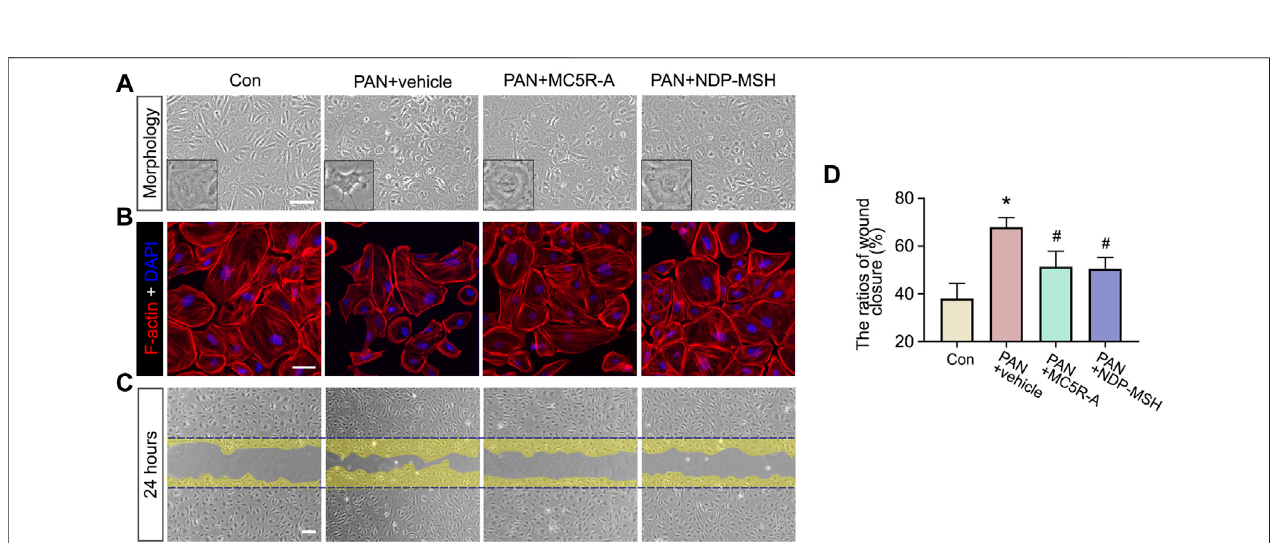
FIGURE 4 | MC5R agonism protects podocytes against PAN-induced disruption of cytoskeleton integrity and podocyte hypermotility. Podocytes were treated with PAN after pretreated with MC5R-A, NDP-MSH or vehicle for 30 min. (A) Representative phase-contrast micrographs show podocyte shape changes (Scale bar = 100 μ m). (B) Cells with different treatment were fi xed and subjected to F-actin staining followed by DAPI counterstaining (Scale bar = 50 μ m). (C) Con fl uent monolayers of podocytes were scraped with a 10 μ L pipette 30 min after different treatments. Representative micrographs taken at 24 h were shown. The cell migration areas were marked as yellow (Scale bar = 100 μ m). (D) Computerized morphometric analysis of wounding areas following the indicated treatments. Data were expressed as the ratios of wound closure. p p < 0.05 versus control (Con) group; # p < 0.05 versus PAN + vehicle group ( n = 3).